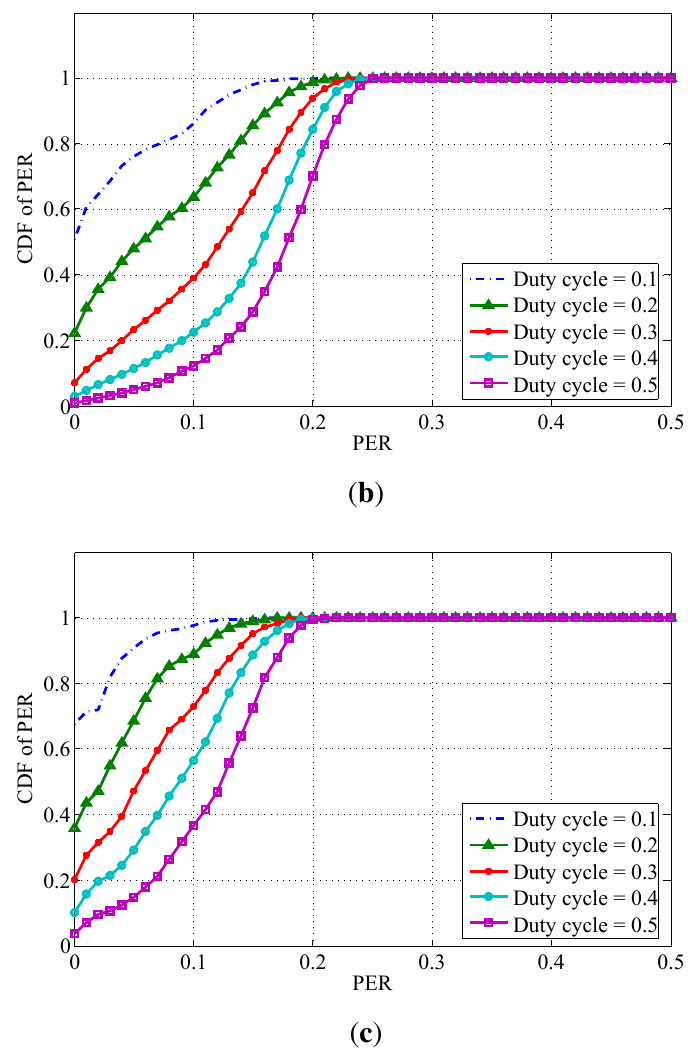
Figure 3. The cumulative distribution function (CDF) of packet error rate (PER) for three scenarios. ( a ) Peak time scenario; ( b ) Moderate time scenario; ( c ) Off-peak time scenario. Table 3. Reliability level (%) with PER lower than